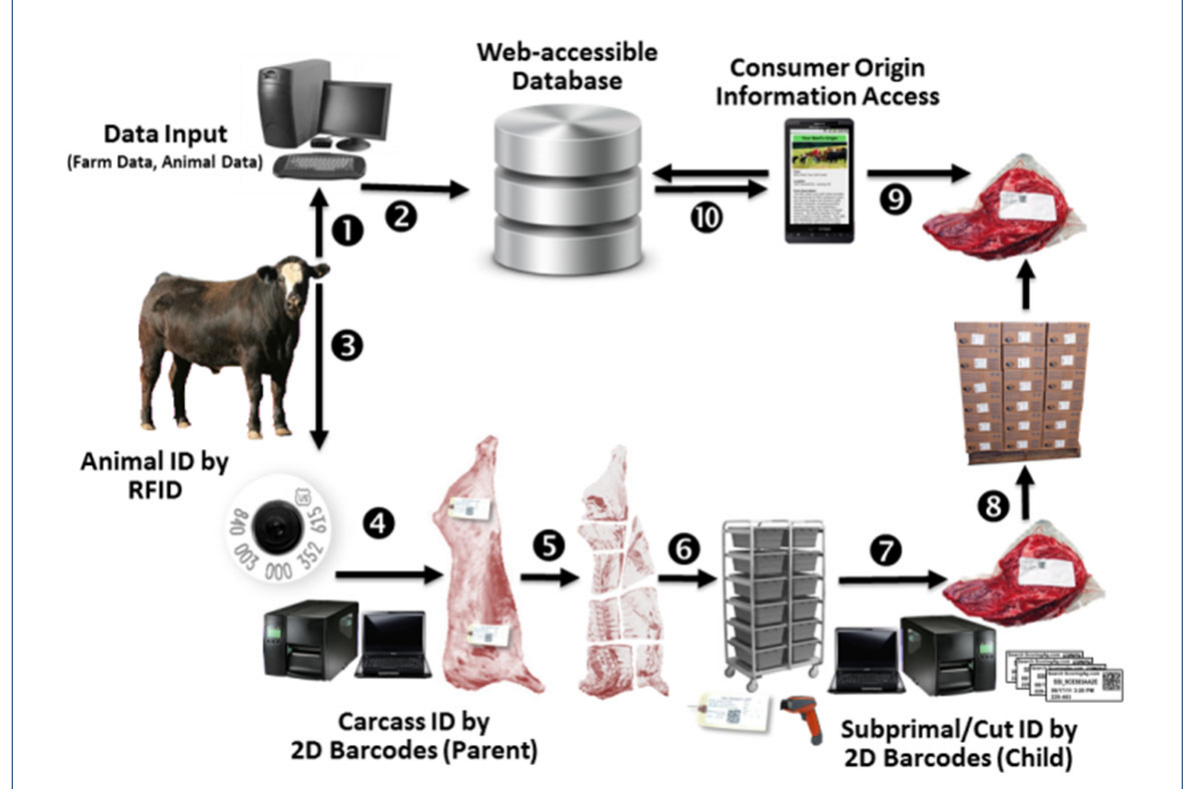
Figure 1. Schematic of Farm-to-Consumer Traceability